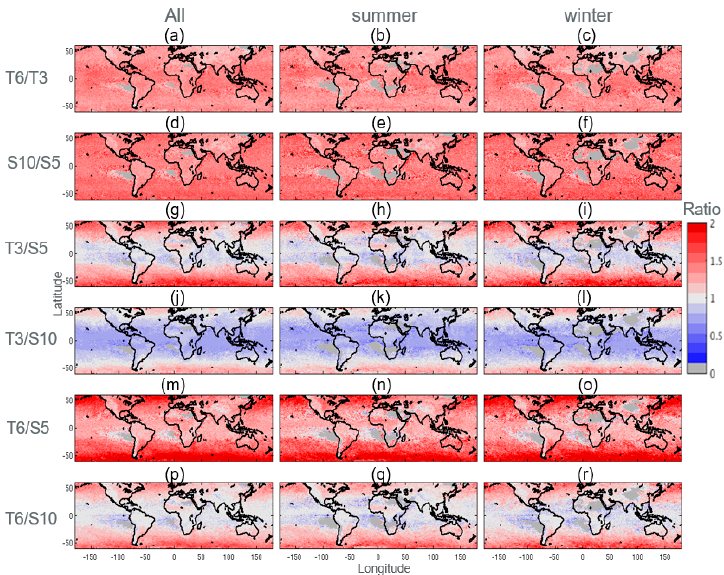
Figure 4. Ratio of relative errors calculated for different combination of T3, T6, S5, and S10.